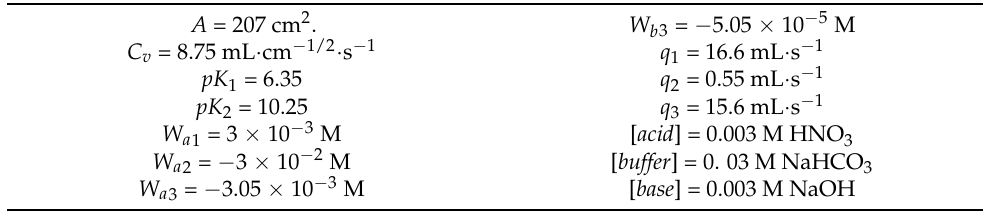
Table 1. The parameters of the